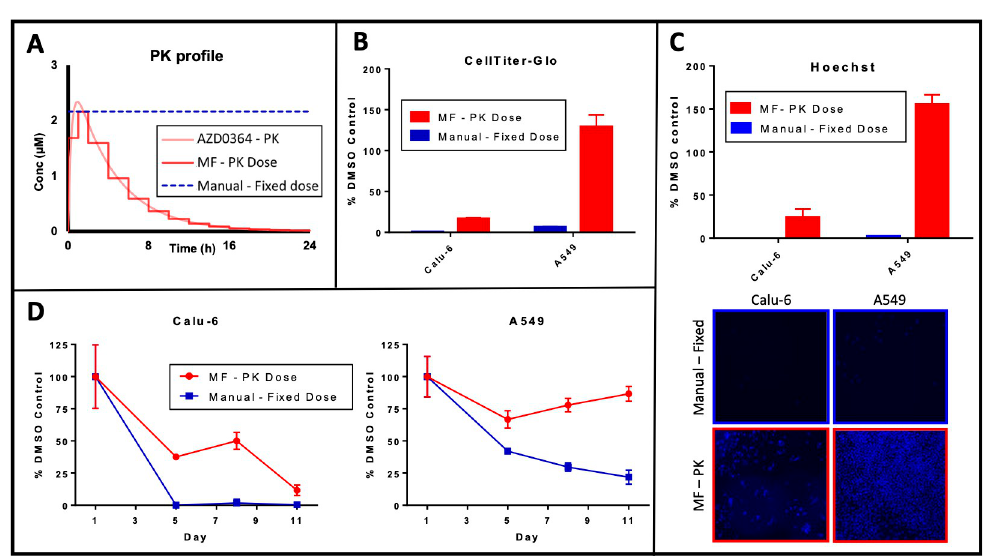
Fig 3. ERK1/2 inhibitor AZD0364 in vivo PK profile replicated on the Microformulator in vitro demonstrates differential activity in KRAS mutant cell lines. (A) In vivo PK profile of AZD0364 (50 mg/kg QD) in murine models (light red) was replicated in vitro using the Microformulator (deep red), where each dosing step represents a 1- or 2-hour interval. A manual fixed dose (equivalent to maximum dose delivered by Microformulator) was performed alongside the Microformulator in typical in vitro conditions with media and drug replenishment every 72 hours. (B, C, D) Growth inhibitory response (B), determined through CellTiter-Glo endpoint ATP quantification normalised to DMSO control on D6. Data represent mean ± SEM of 3 technical replicates. Hoechst DNA analysis (C) performed on images normalised to DMSO control on D11. Data represent mean ± SEM of 3 images. Growth inhibitory response further determined (D) from confluency analysis of brightfield images normalised to DMSO controls, of KRAS mutant cells Calu-6 and A549 to AZD0364 delivered by the Microformulator each day over 11 days of treatment (red) or as a fixed dose (2.16 μ M) (blue). Data represent mean ± SD of 3 technical replicates. Underlying data can be found in S1 Data. PK, pharmacokinetic.